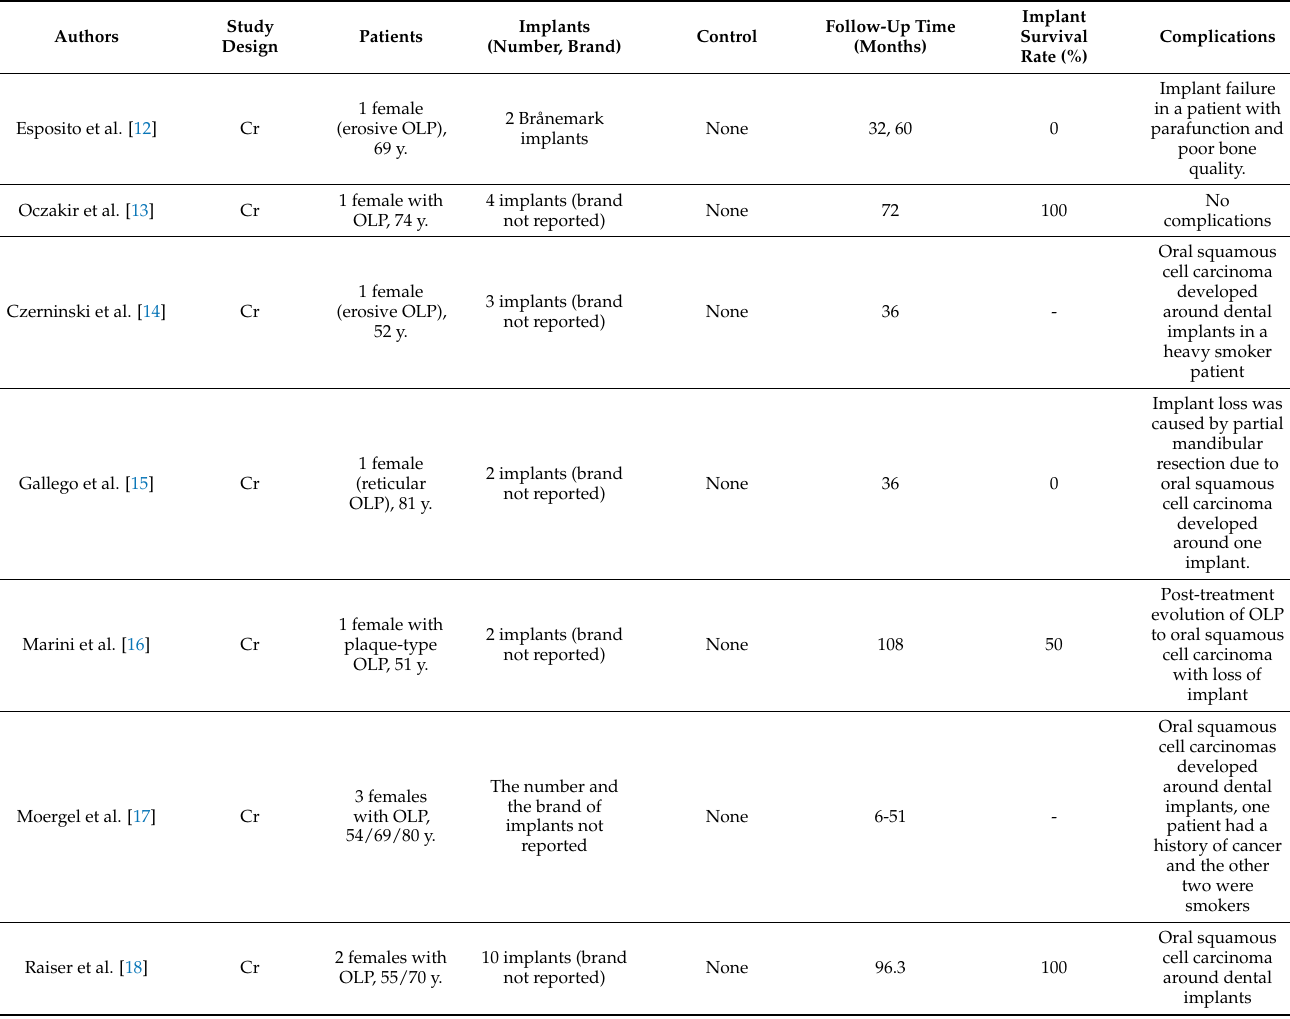
Table 1. Main characteristics of the selected studies and summary of reported